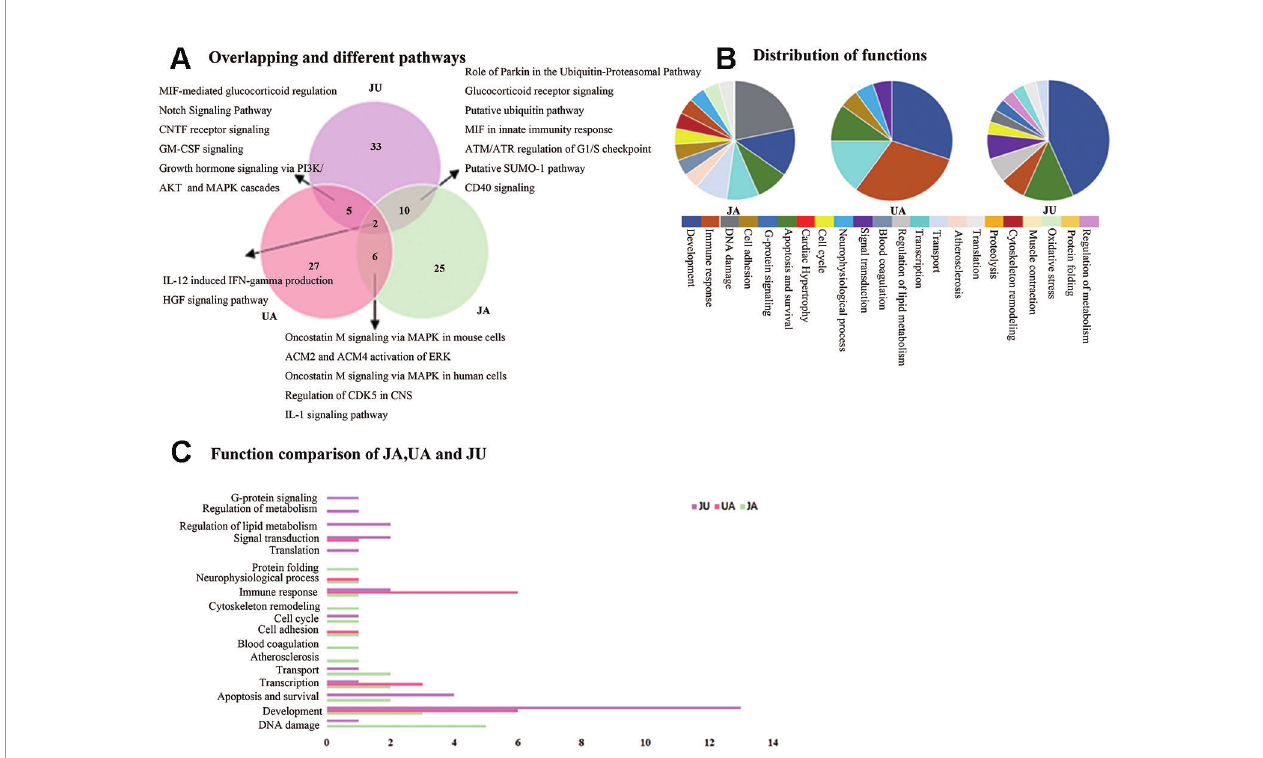
FIGURE 2 | The Wayne fi gures of overlapping and different biological functions and pathways among groups. UA (red) denotes UA vs. CM groups and JU (purple) denotes JU vs. CM groups. (A) The Wayne fi gures of overlapping and different pathways among JA, UA, and JU. (B) The function distribution among JA, UA, and JU. (C) The functional comparison among JA, UA, and JU. Only signi fi cant functions are shown in this fi gure based on a P value <0.05 and a fold change >1.5 between